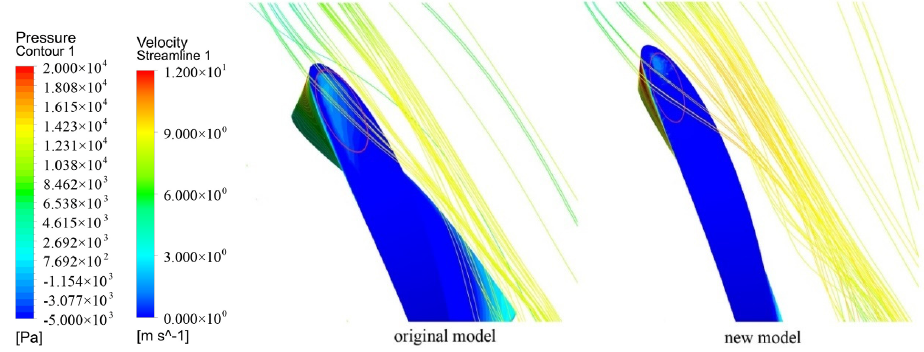
Figure 14. Pressure distributions of rear blade and streamlines at rear tip clearance area.